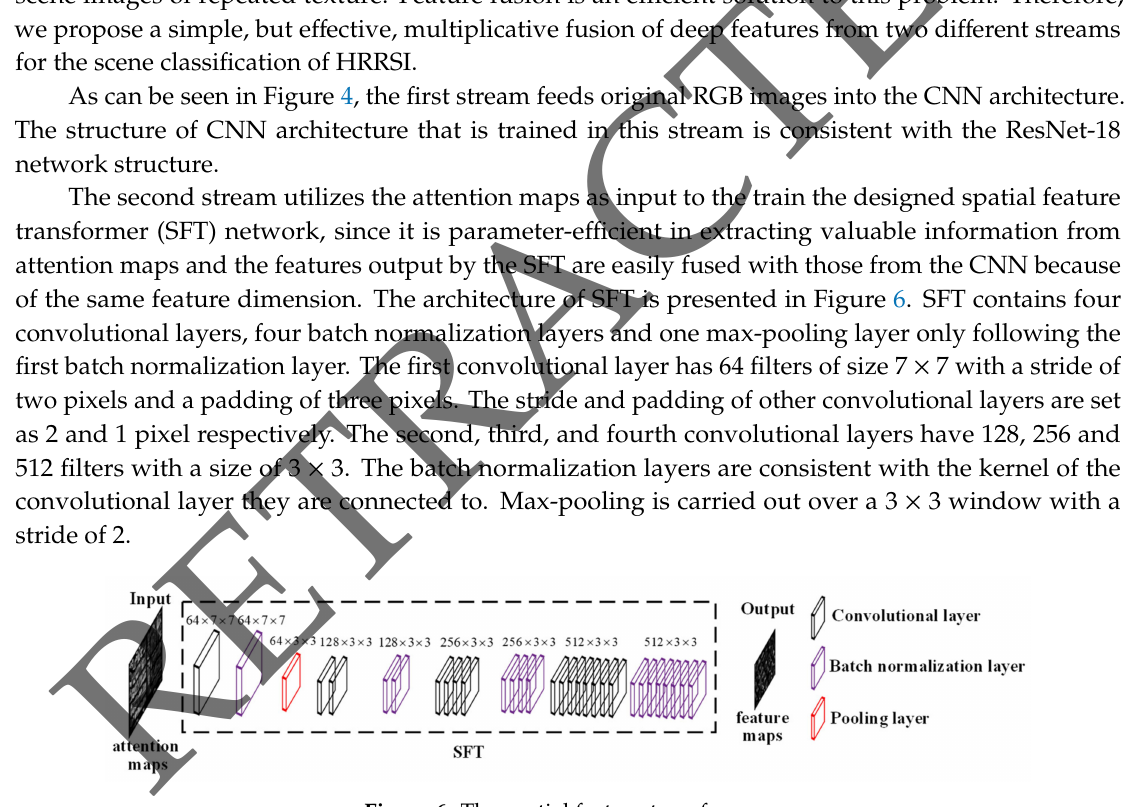
Figure 6. The spatial feature